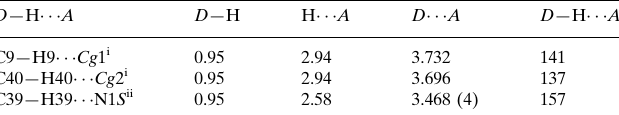
Hydrogen-bond geometry (A˚ , (cid:4)